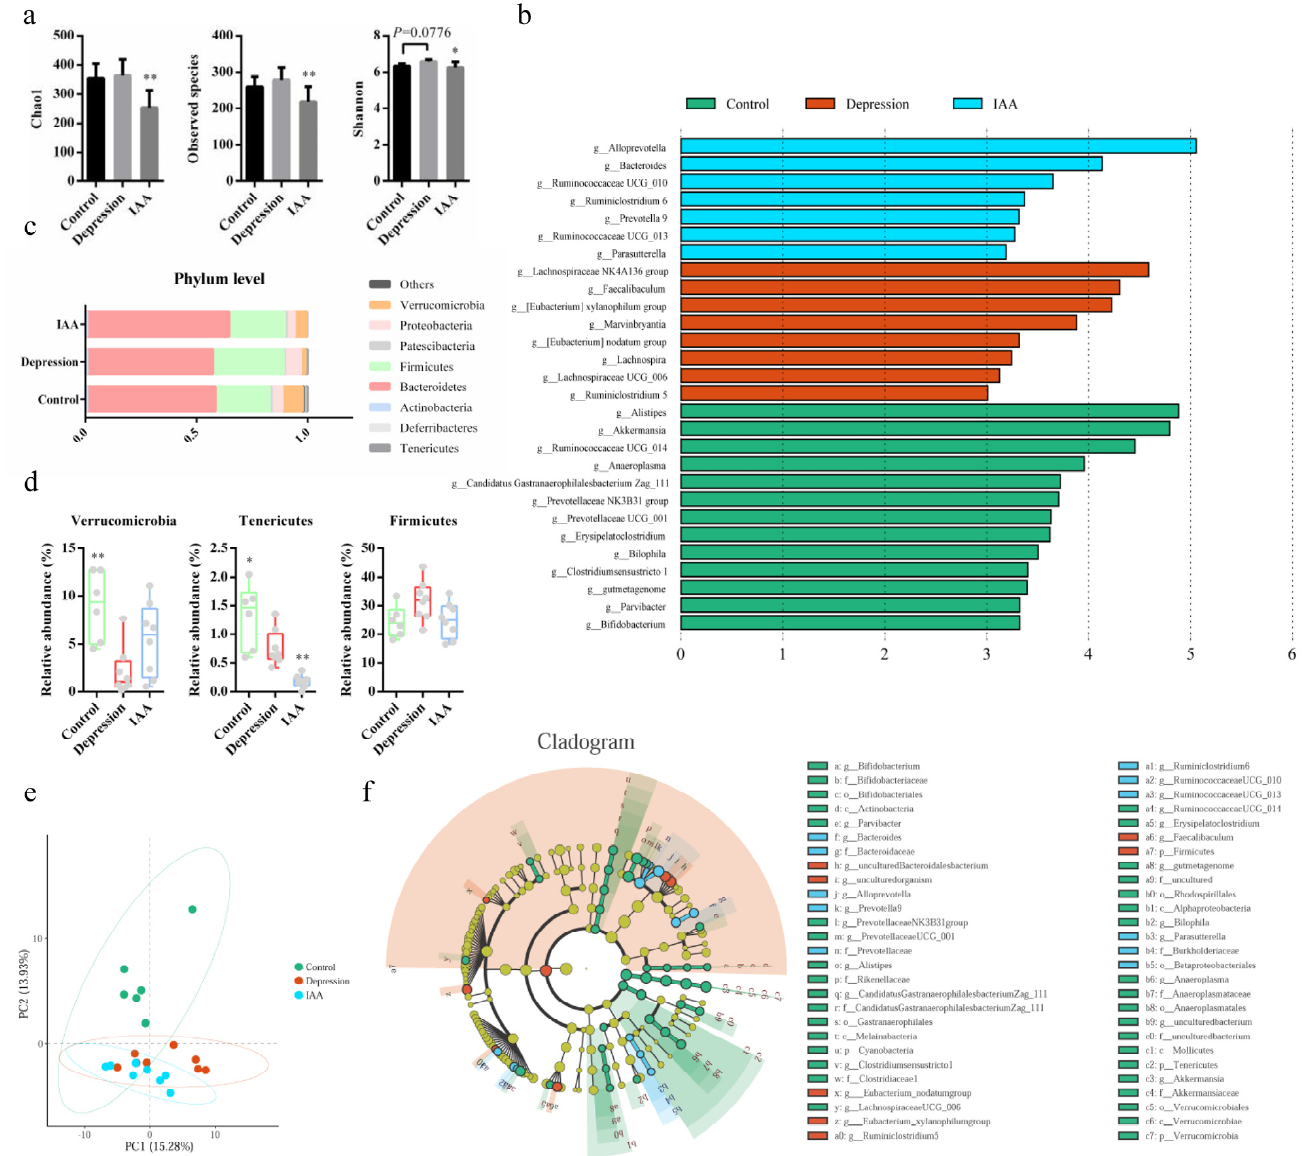
Figure 5. Microbial diversity in the colonic content. ( a ) Alpha-diversity analysis of the gut microbiota in the experimental groups. ( b ) LDA of bacterial composition at the genus level. ( c , d ) Relative abundance and STAMP analysis of microbial communities at the phylum level. Compared with the depression group, * p < 0.05, ** p < 0.01; data are presented as means and SD, one-way ANOVA followed by Tukey’s post hoc test. ( e ) PCA plot of OTU abundance. ( f ) LEFSe comparison of microorganisms among control, depression and IAA groups.